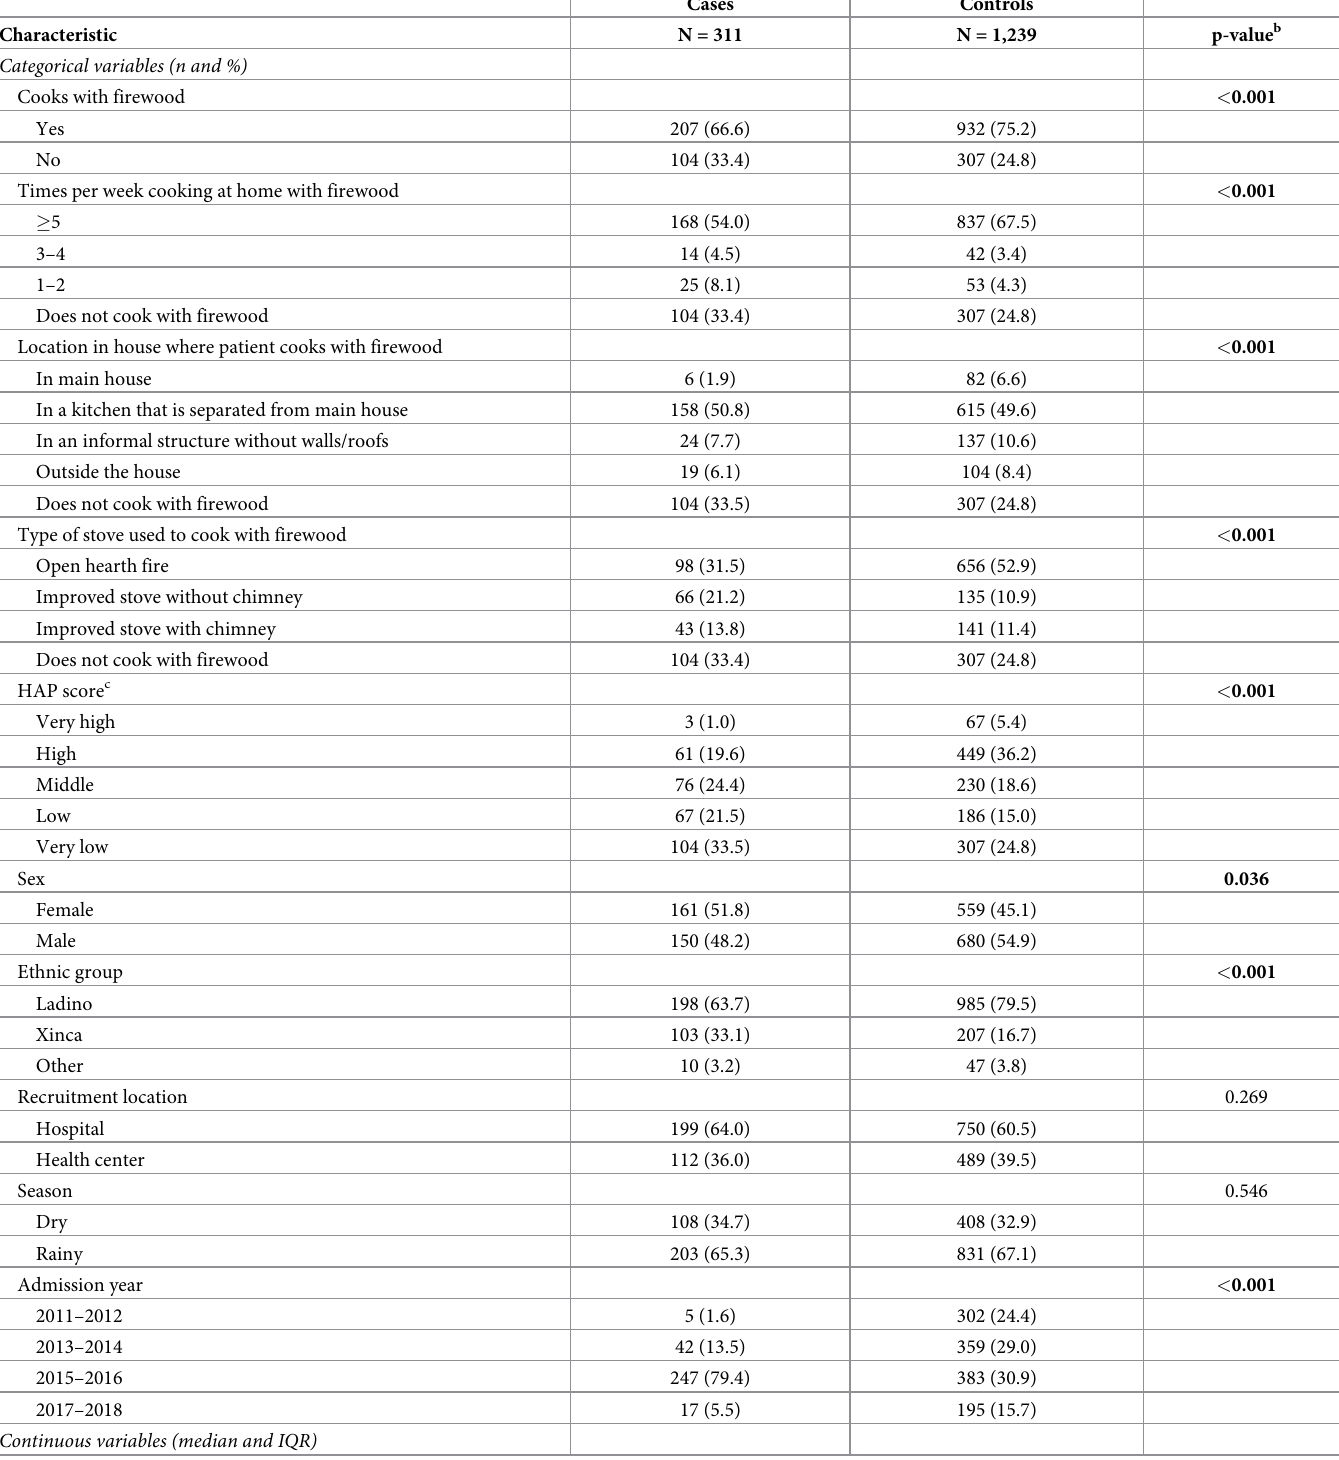
Table 2. Cases with confirmed arbovirus infection (dengue, chikungunya, or Zika virus) and controls with confirmed diarrheal infections a , Santa Rosa, Guatemala, 2011–2018.